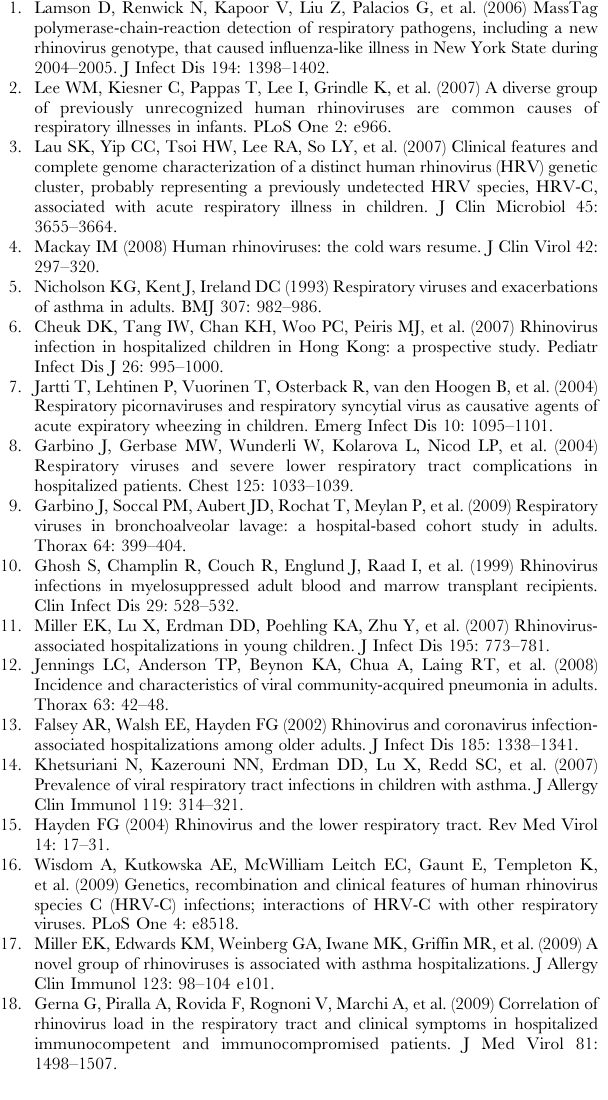
Table S1 Laboratory methods used to identify respiratory